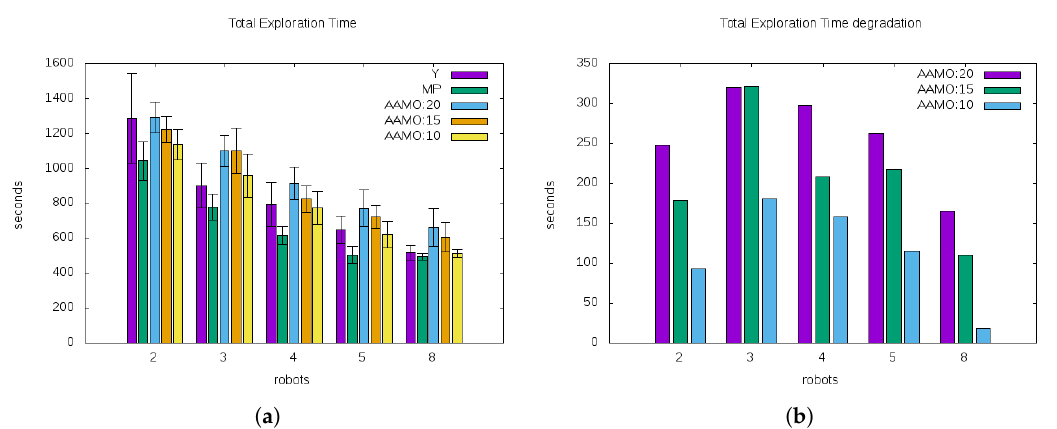
Figure 18. AAMO Total Exploration Time (TT) under non-ideal communication conditions and Degradation with respect to baseline results. ( a ) All AAMO instances show a decreasing trend of TT as the fleet size increase. The Yamauchi and MinPos approach results (coloured in purple and green, respectively) obtained under ideal communication conditions are placed together to make the comparison easier; ( b ) The degradation is expressed in terms of the difference between the TT achieved by each of the AAMO instances and the one achieved by the MinPos approach, for each fleet